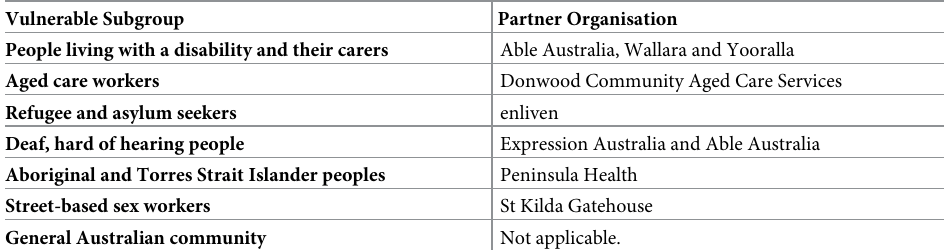
Table 2. Partner organisations related to each subgroup